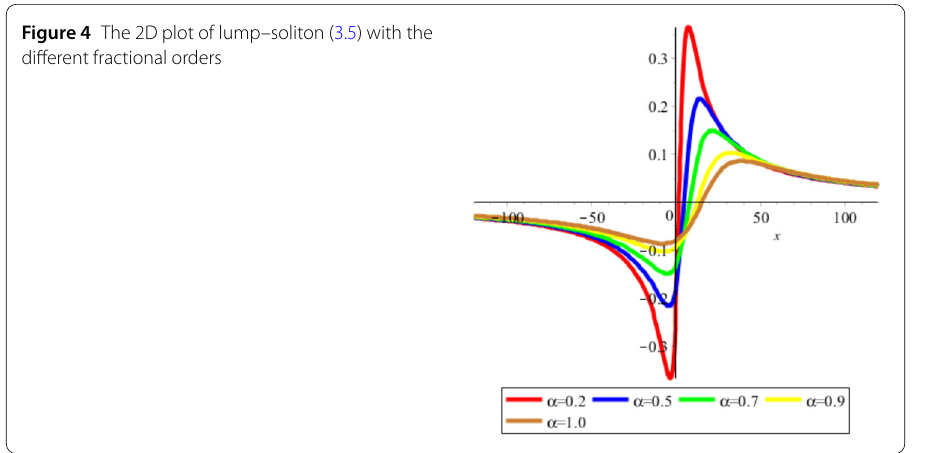
Figure 4 The 2D plot of lump–soliton (3.5) with the different fractional